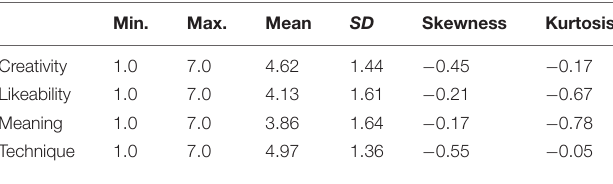
TABLE 2 | Descriptive statistics of creativity, likeability, meaning and technique ratings.